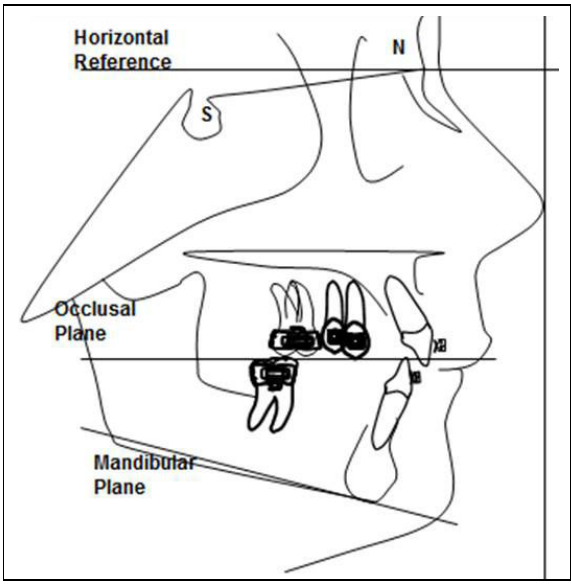
Figure 9. X-Y Coordinate system used in customised cephalometric